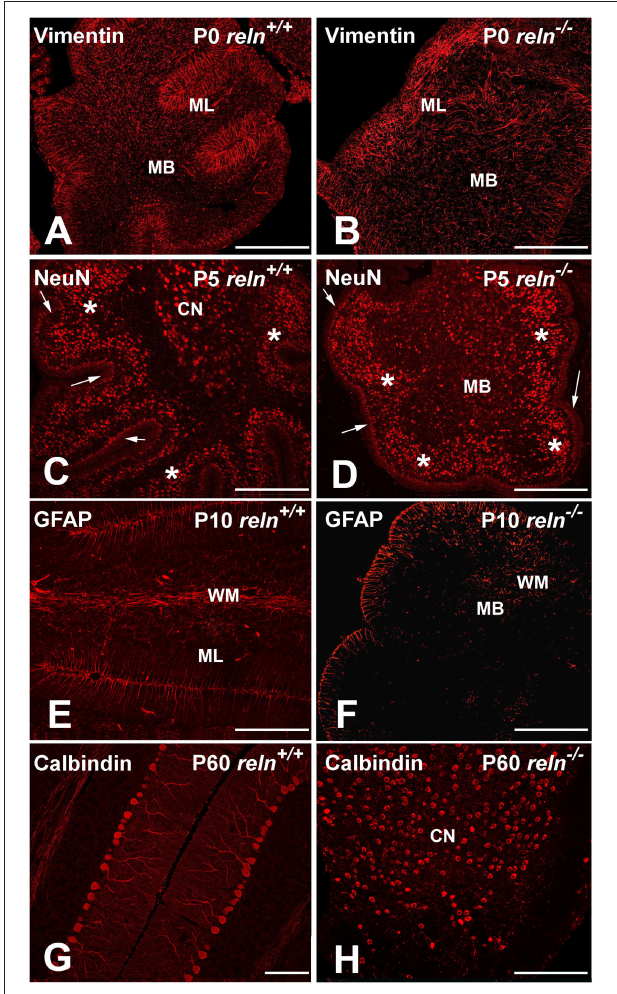
FIGURE 2 | Exemplificative images of the neurochemistry of the postnatal cerebellar cortex in normal and mutant mice. Immunocytochemistry shows that the timing of expression of the main neuronal/glial markers in cerebellum is not affected by the reln mutation. (A,B) From P0, vimentin starts to be expressed by the Bergmann glial and the glial cells in the white matter. In the reln − / − ML, the Bergmann glia is poorly oriented along radial planes in comparison with controls (arrows). (C,D) NeuN is expressed, starting from P5, by the granule cells of the deep post-mitotic portion of the EGL (marked by arrows), the post-migratory granule cells in the IGL (asterisks) and the deep nuclei neurons (white dashed lines); (E,F) starting from P10, GFAP is detected in the Bergmann glia and white matter glial cells. (G,H) show calbindin immunoreactive Purkinje neurons in young adult mice (P60). The two images highlight the aberrant positioning of these neurons at the end of cerebellar development in reln − / − mice, when compared to littermate controls. In mutants, positive Purkinje neurons in the medullary body are intermingled with immunoreactive neurons of the cerebellar nuclei. BG, Bergmann glia; CN, cerebellar nucleus; EGL, external granular layer; IGL, internal granular layer; MB, medullary body; ML, molecular layer; P, postnatal age; PNs, Purkinje neurons. Scale bars: (A–F,H) = 100 µ m; (G) = 30 µ